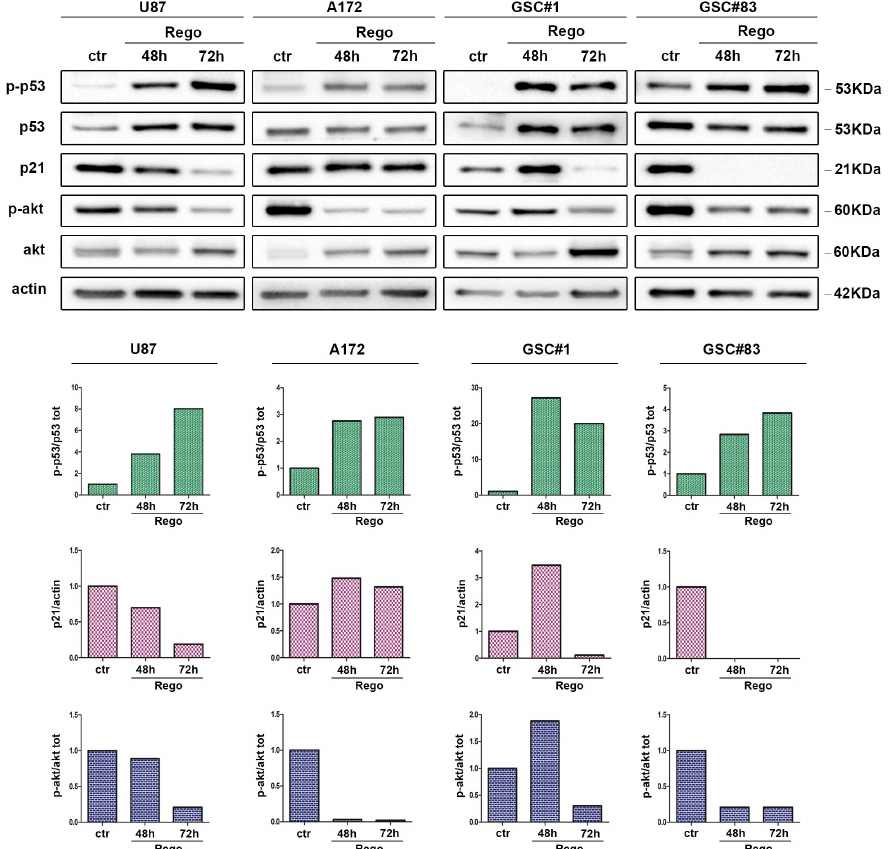
Figure 4. Protein expression of apoptosis-related proteins in regorafenib-treated GBM cells. U87, A172, GSC#1, and GSC#83 were treated with regorafenib for 48 and 72 h. Figure shows a representative Western Blot analysis of total and phosphorylated p53 protein, of p21, and of phosphorylated AKT, analyzed as an indirect strategy to confirm regorafenib effectiveness in our cells. Actin was used as protein-loading control (Original western blot can be found in Supplementary Figure S4). Graphs report quantitation of the proteins levels as addressed by Image